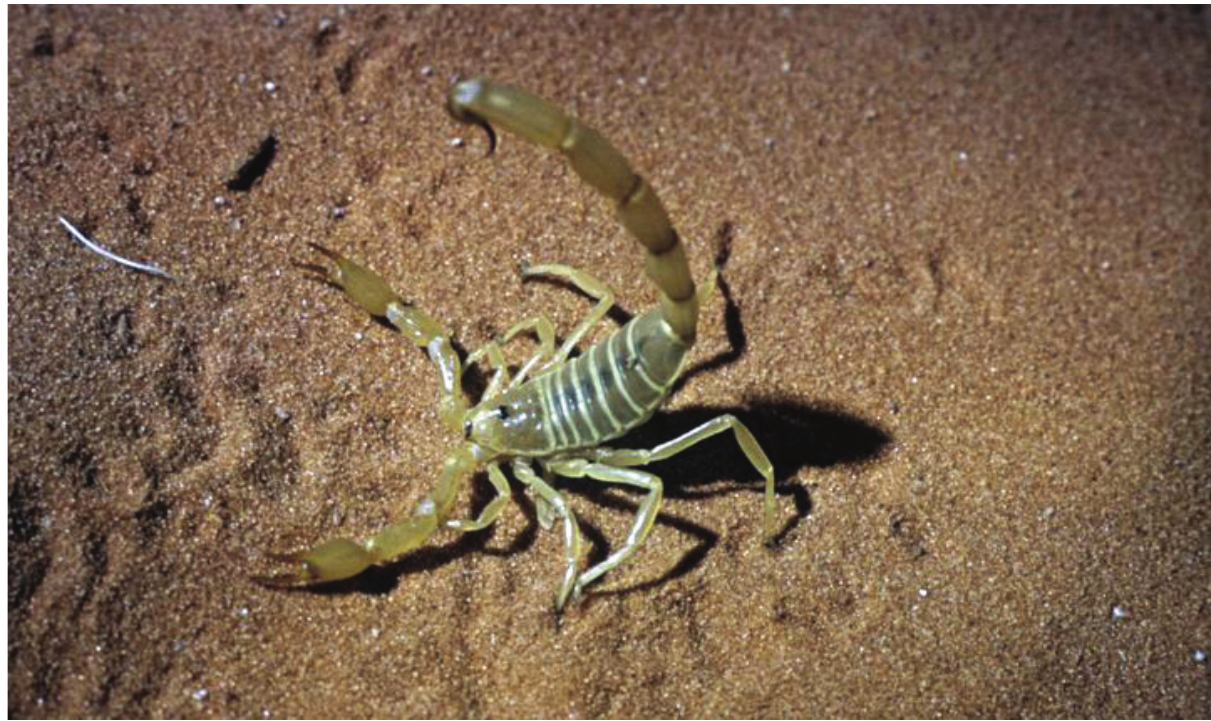
Figure 2. Buthiscus bicalcaratus , a harmless scorpion, principally described in southern Tunisia or southern Algeria. It is a Saharan species which is probably common in northeastern Mali